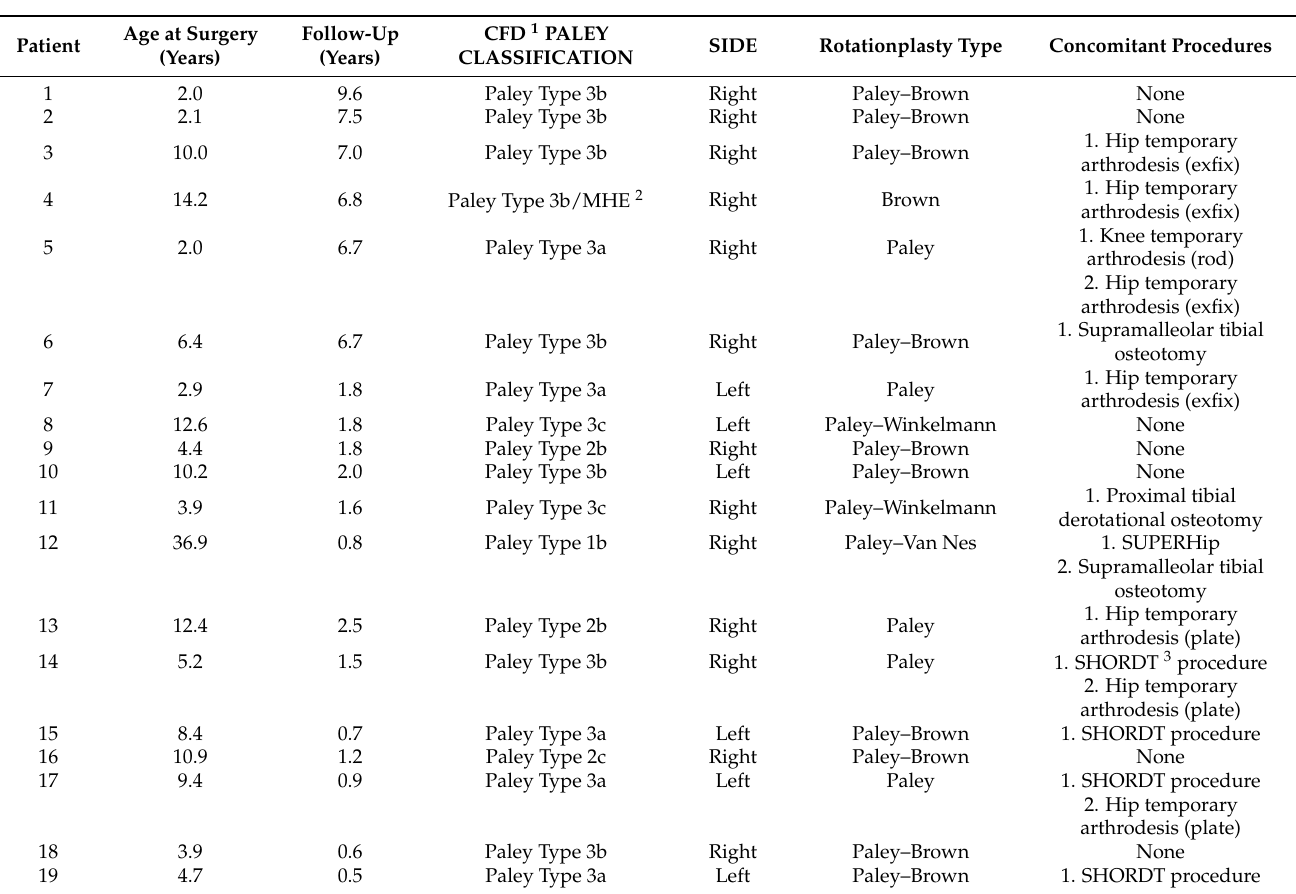
Table 1. Patient